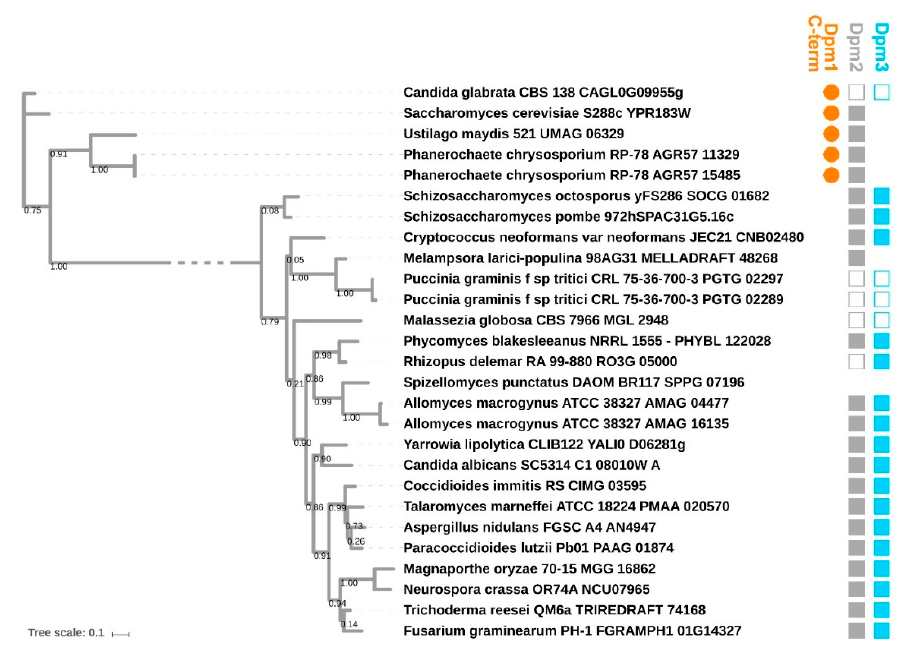
Figure 3. Maximum likelihood phylogenetic tree of catalytic subunit Dpm1 of dolichyl diphosphate mannose synthase (DPMS) in selected representative fungi. Species names are followed by gene identifier. Orange circles denote presence of C-terminal hydrophobic α -helix in Dpm1, grey and blue squares indicate presence of Dpm2 and Dpm3, respectively. Empty squares indicate that the corresponding subunit has not been reported for a given species but is present in other species from this genus. Bootstrap support values are provided at corresponding